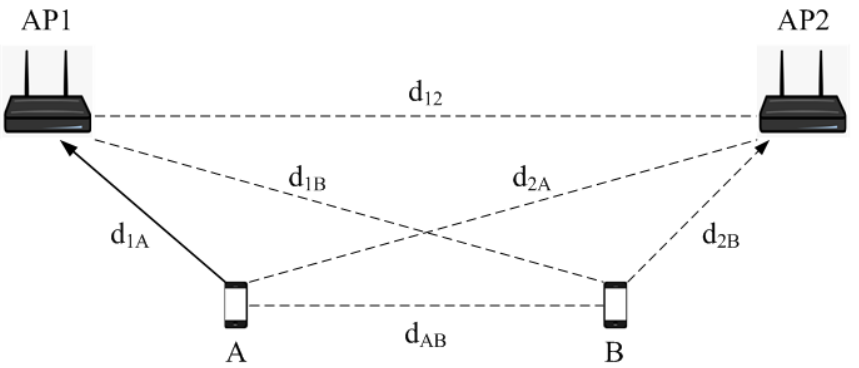
Figure 5. A scenario illustrating how a node determines concurrent transmission in the pro- posed